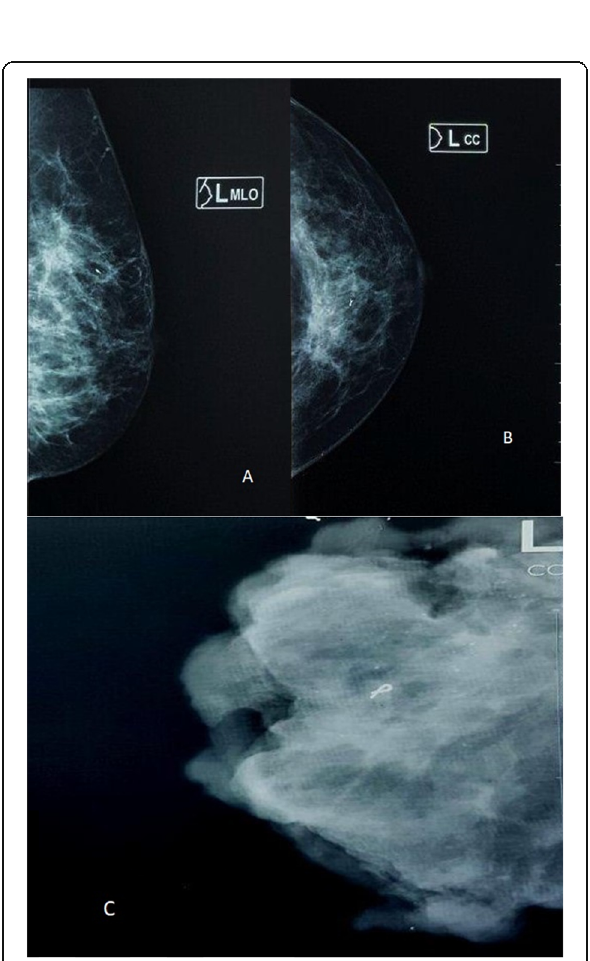
Fig. 2 A 55-year-old female presented with left breast lump proved to be IDC grade I. Left breast MLO a and CC b view show UIQ clip. No wire localization was done as the mass was palpable. Intraoperative specimen mammography c show clip